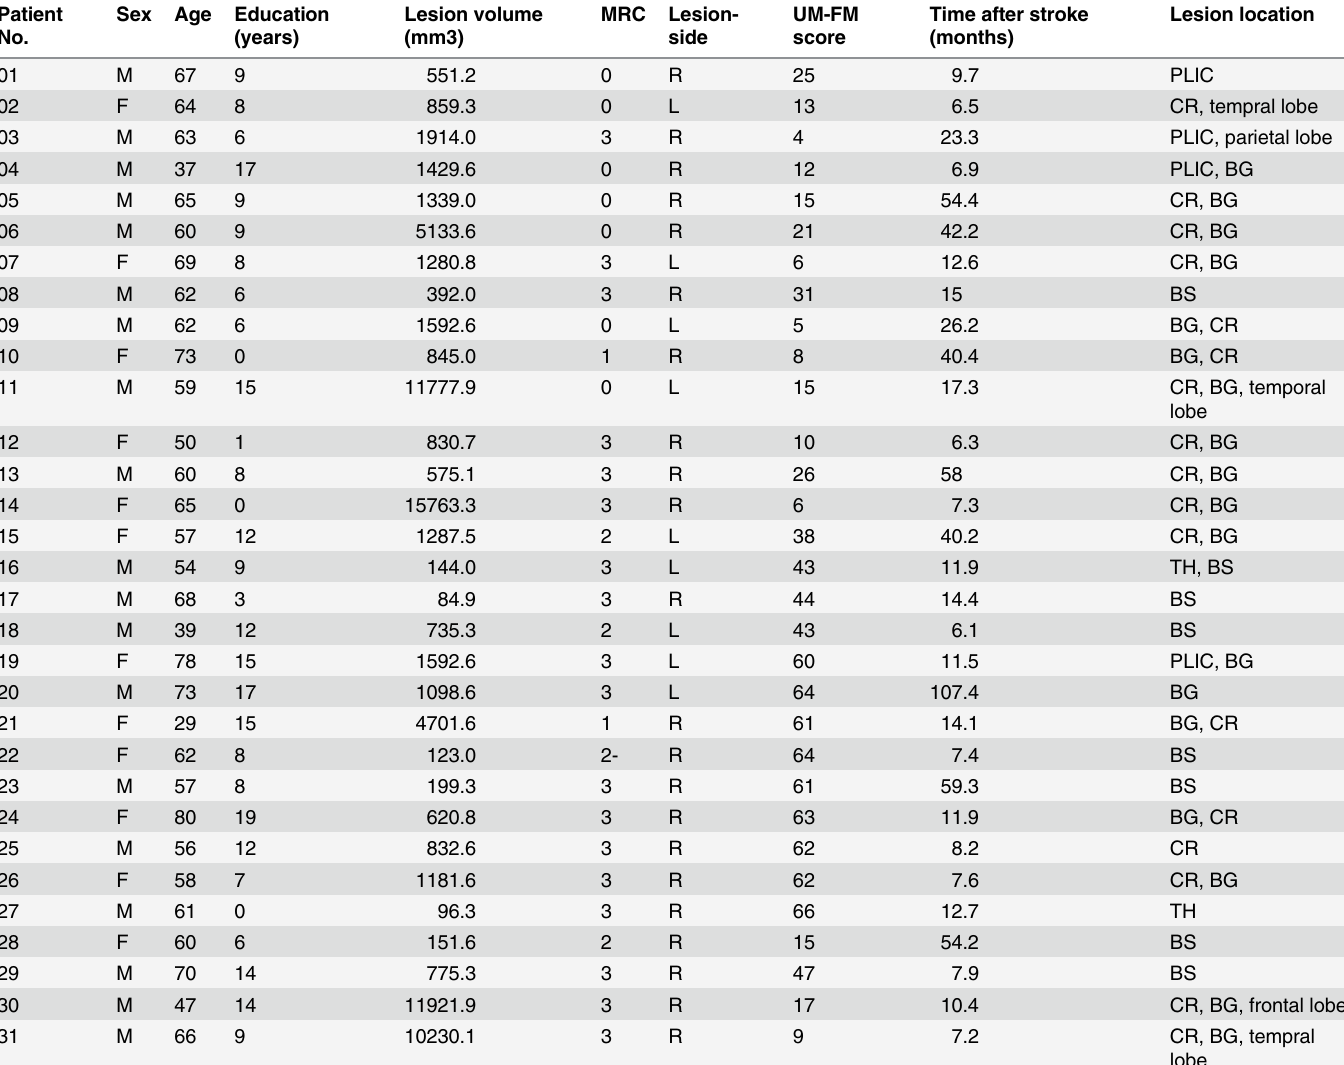
Table 1. Demographic and clinical findings for 31